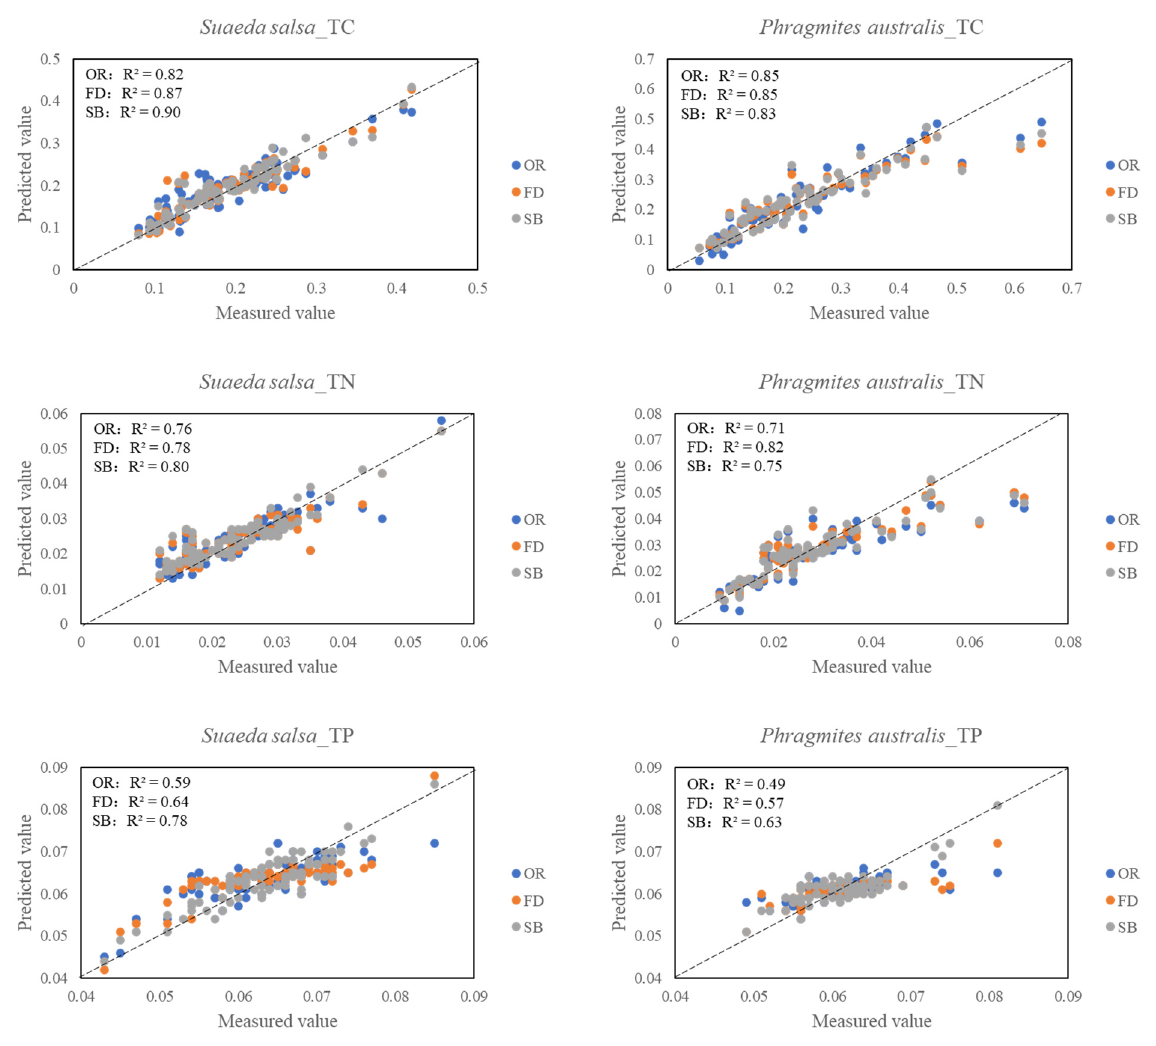
Figure 8. SVM modelling results for P. australis and S. salsa . OR: original reflectance; FD: first derivative reflectance; SB: sensitive band.